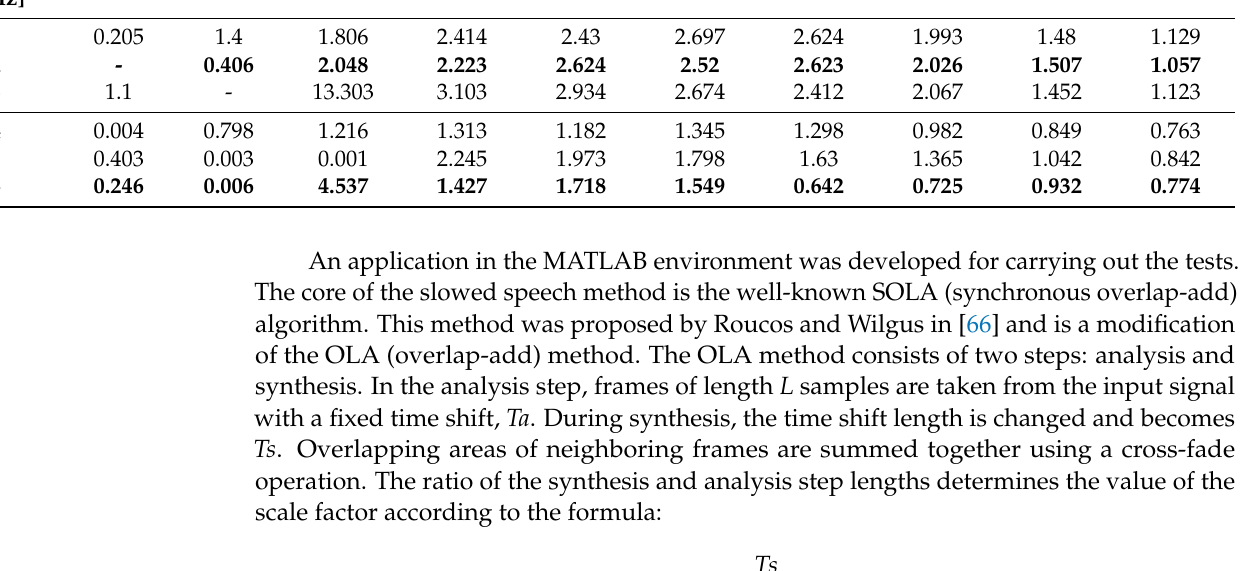
Table 3. Reverberation times for the impulse responses collected in the study (bold denotes values corresponding to impulse responses with the lowest and highest STI values). Resp.